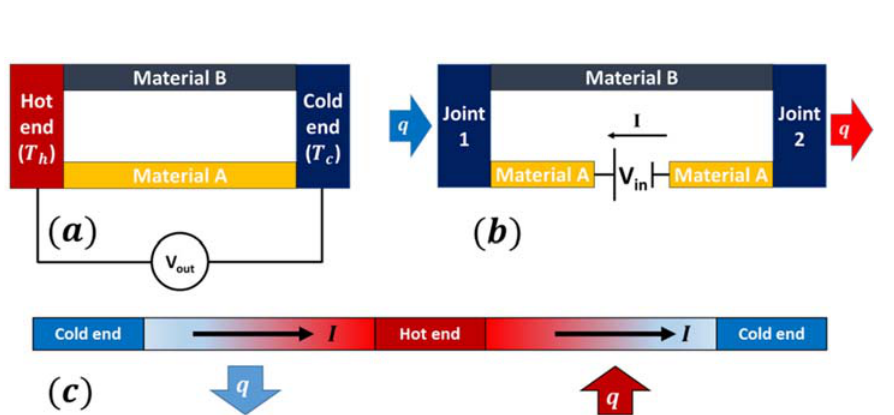
Figure 3. ( a ) Seebeck effect: Two thermoelectric materials joined at hot and cold junctions, which are maintained at temperatures T h and T c (temperature difference ∆ T = T h − T c ). Seebeck EMF of V out is obtained across the junctions; ( b ) Peltier effect: Two thermoelectric materials joined at the two ends. An electric current ‘I’ is passed through the circuit and heat q is evolved at one end and absorbed at the other; ( c ) Thomson effect: due to spatial gradient in temperature and current, a continuous version of the Peltier effect occurs, resulting in Thomson heat.